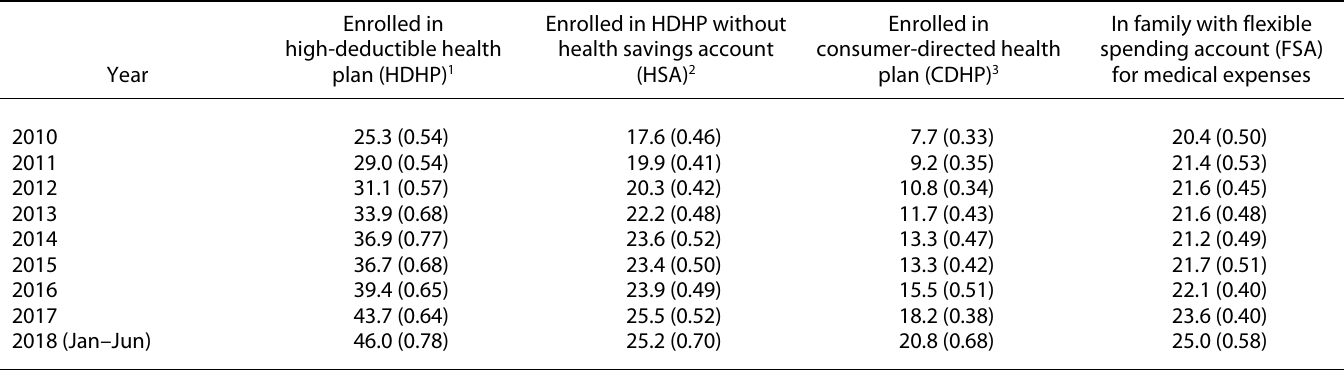
Table XI. Percentages (and standard errors) of persons under age 65 with private health insurance coverage who were enrolled in a high-deductible health plan, in a high-deductible health plan without a health savings account, and in a consumer-directed health plan, and who were in a family with a flexible spending account for medical expenses, by year: United States, 2010–June 2018